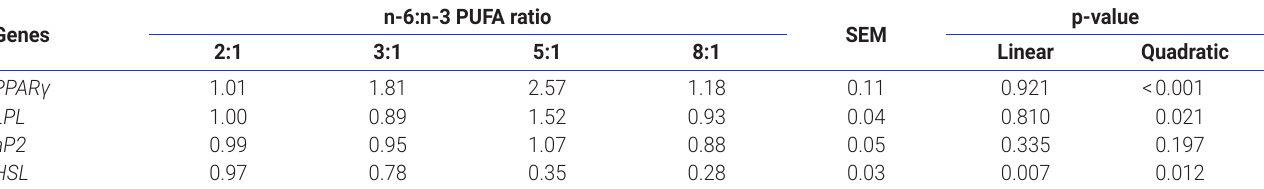
Table 8. Effects of dietary n-6:n-3 PUFA ratios on the relative mRNA expression levels of genes in the LT of pigs